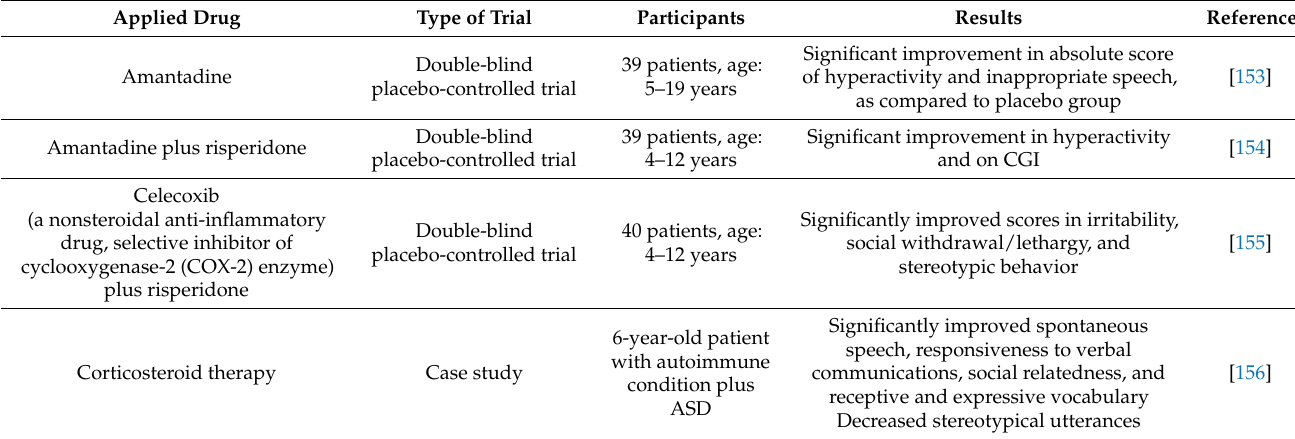
Table 2. Summary of the studies on the role of anti-inflammatory medications in ASD